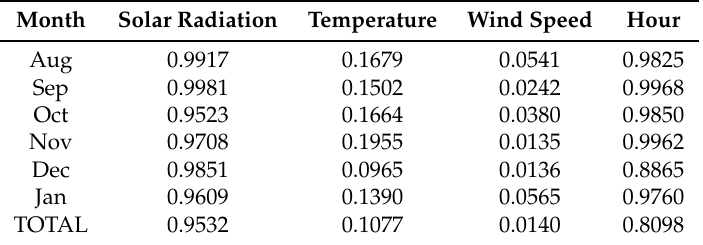
Table 3. The determination coefficients (R 2 ) of every input from HS.